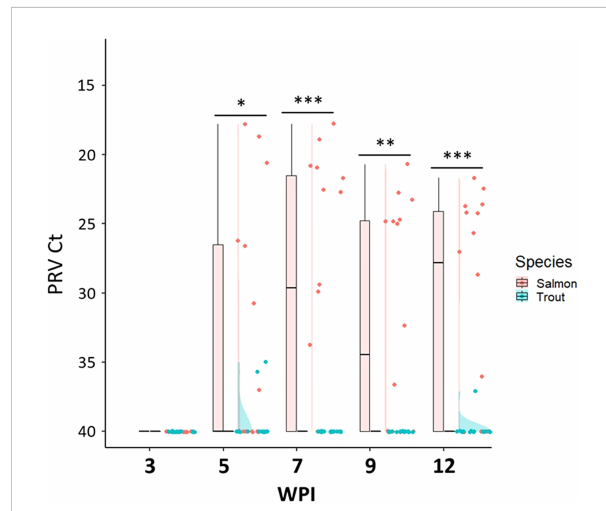
FIGURE 3 Raincloud plots comparing the PRV-1 viral load in salmon and trout parr after the cohabitation challenge. Asterisk (* P < 0.05; ** P < 0.01; *** P < 0.001) indicate signi fi cant differences based on Welch ’ s two sample